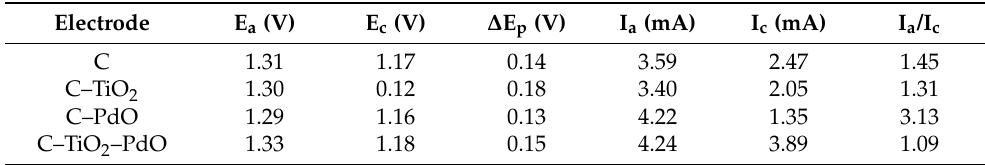
Figure 2. Cyclic voltammograms for 0.01 M Ce(NO 3 ) 3 · 6H 2 O/0.1 M CH 3 SO 3 H solution. Table 2. Electrochemical characteristics of 0.01 M Ce(NO 3 ) 3 · 6H 2 O solution on various electrodes with 0.1 M CH 3 SO 3 H as a supporting electrolyte.